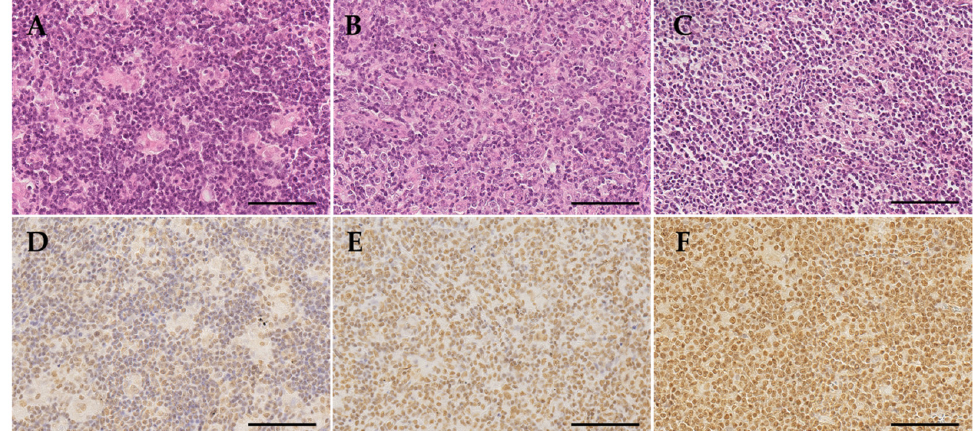
Figure 2. Histomorphology and RBMX immunohistochemistry. All samples were stained with hematoxylin and eosin (H&E) as exemplary shown in micrographies ( A – C ). The immunohistochemical stains for RBMX were examined and evaluated in conjunction with the H&E stains. Immunohistochemical staining showing low ( D ), middle ( E ), and high ( F ) levels of nuclear RBMX expression. Original magnification ×40, the scale bars are 100 µm.